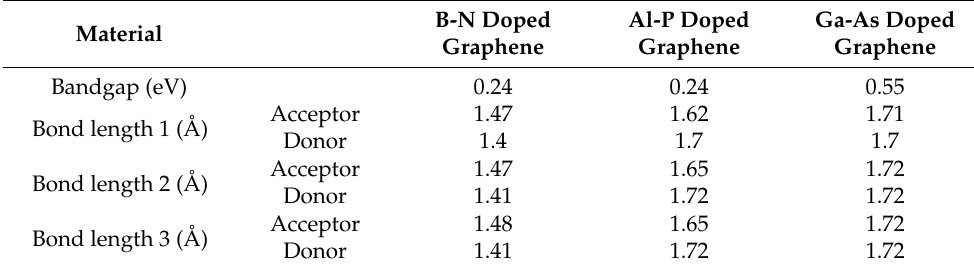
Table 1. Induced bandgap and C—dopant bond length in different doped graphene. Material Bandgap (eV)